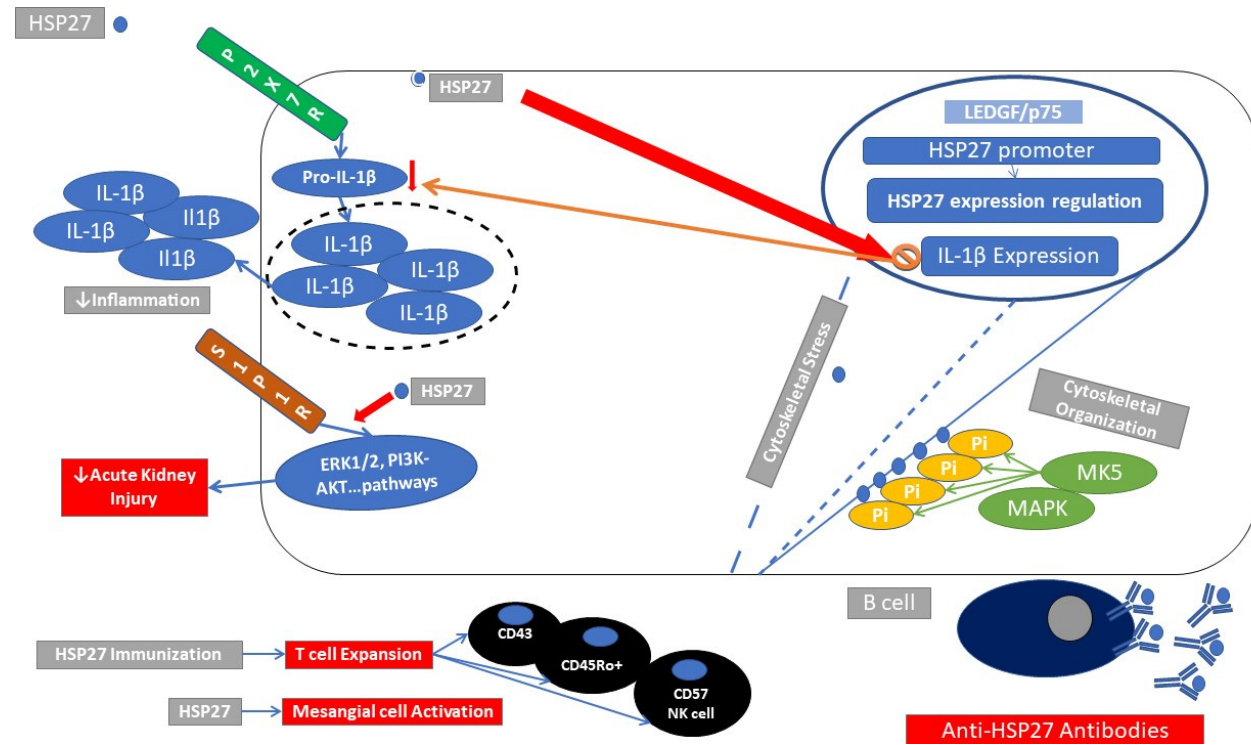
Figure 2. Immunomodulatory actions of HSP27. HSP27 (blue circle) participates in cytoskeletal integrity in cases of cellular distress. Phosphorylation of the N-terminal domain of HSP27 through MAPK kinase protects against cytoskeletal disorganization. HSP27 gene expression can be controlled through transcription factors LEGF (lens epithelium growth factor). HSP27 may inhibit mRNA expression of IL-1 β and thus inhibit the production of proinflammatory cytokine IL-1 β and subsequent inflammatory milieu, P2X7R (ATP-gated P2X cation channel receptor). HSP27 activates SIP1R (sphingocine 1 phosphate receptor) signaling, ameliorates renal inflammation, and protects against acute kidney injury (AKI). Proinflammatory actions of HSP27. HSP27 induces mesangial cell activation; immunization with HSP27 leads to expansion of specific T-cell populations (CD43+, CD45Ro+, and CD57+ NK cells) as well as the production of HSP27 autoantibodies.